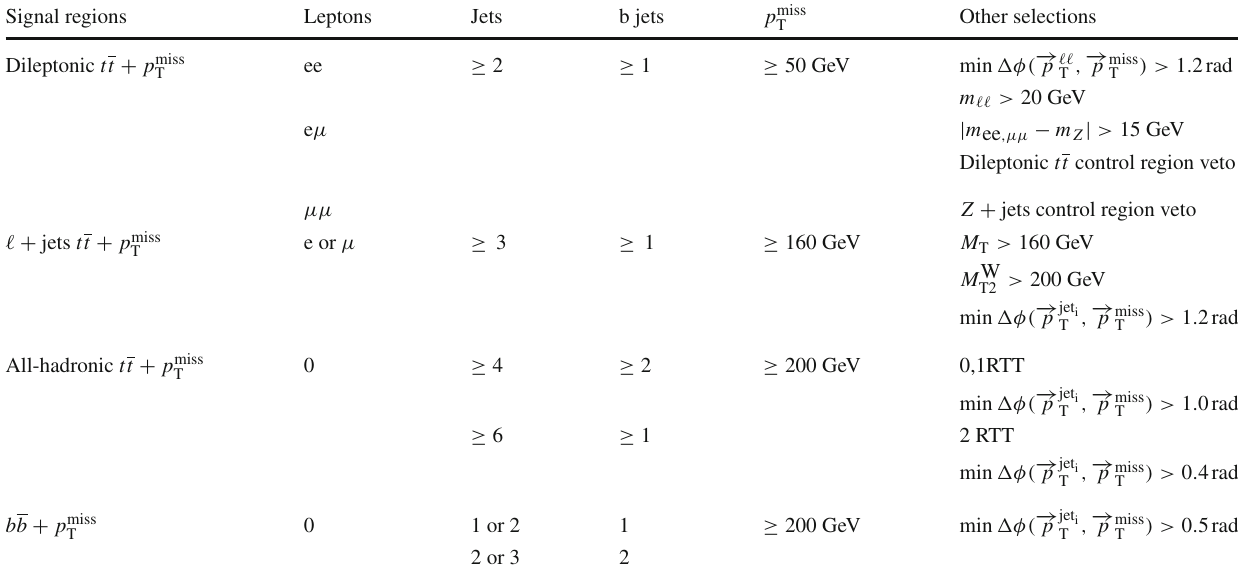
Table 1 Overview of the selection criteria used to define the eight tt + p miss and bb + p miss signal regions. The signal region selections T T (includingthedefinitionsofthevariables M T and M W T2